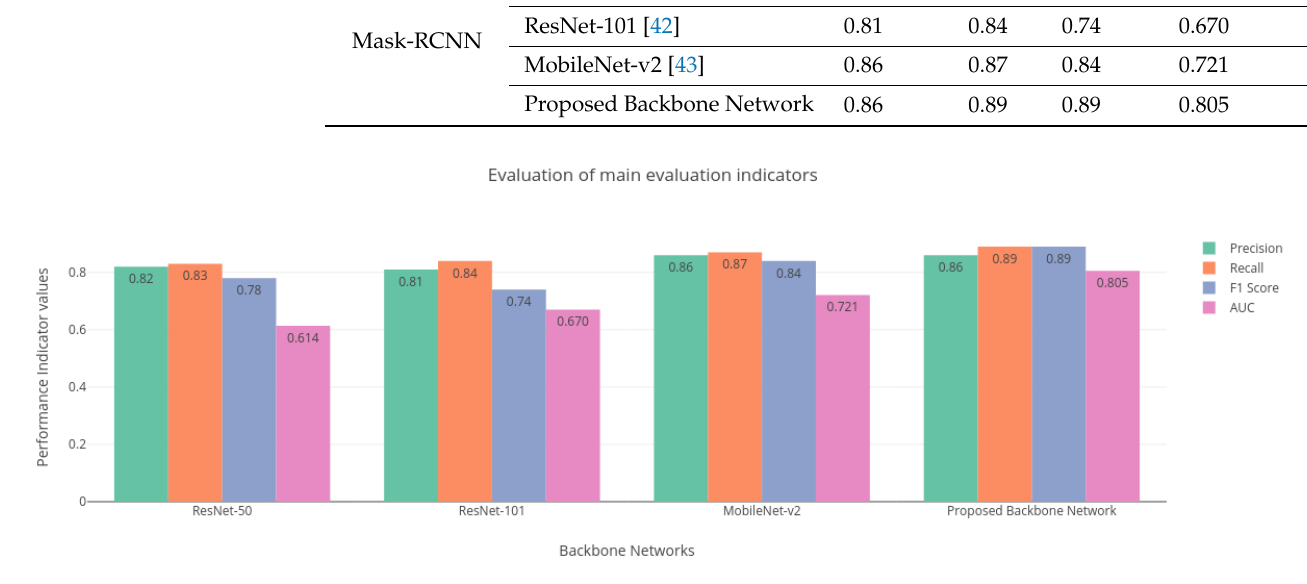
Figure 9. Main evaluation indicators for different backbone